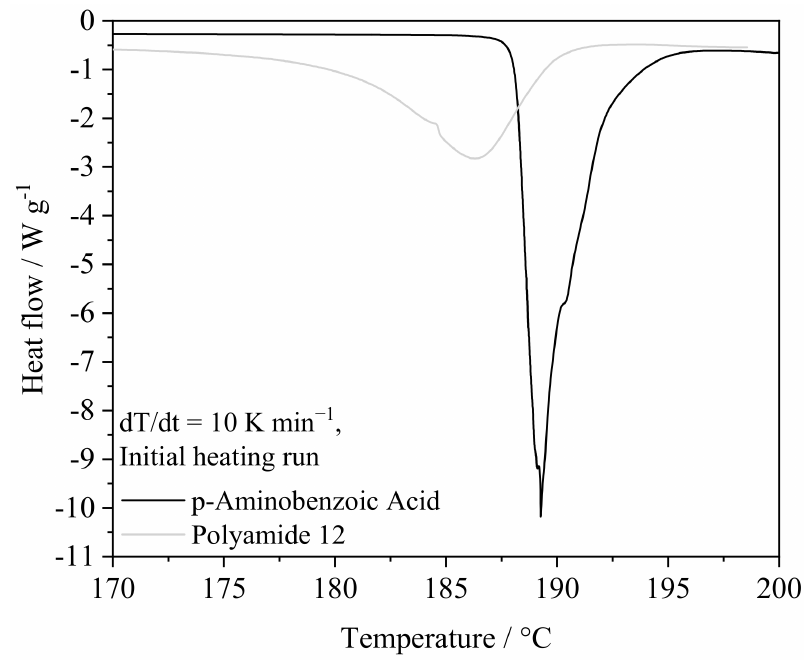
Figure 1. Depiction of differential scanning calorimetric characteristics of PA12 and pABA. Manufactured specimens comprise tensile bars (DIN EN ISO 3167:2014-11, type 1A) scaled by a factor of 0.5. All processing is conducted using an LPBF machine of the type EOS P 396 (EOS GmbH, Krailling, Germany) equipped with a 70 W CO 2 laser with a wavelength of λ = 10.6 µ m. A build chamber insert exhibiting an area of 100 × 100 mm 2 is applied for limiting the required amount of powder blend. Underlying exposure parameters are chosen according to near-optimal parameters for the processing of unmodified PA12, corresponding to a laser power of P = 16.8 W, a hatch distance of d hatch = 0.2 mm, an exposure speed of v = 2000 mm s − 1 , and a layer height of h Layer = 0.12 mm. Alternating meander scanning is specified as the underlying exposure strategy. The underlying process layout is displayed in Figure